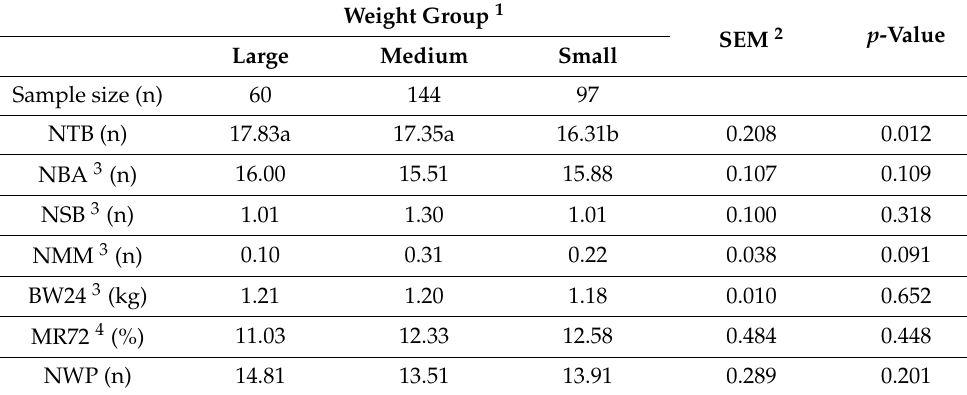
Table 2. Effect of body weight of gilts at first service on reproductive performance parameters from first insemination to first weaning on a commercial farm (NTB: number of total piglets born; NBA: number of piglets born alive; NSB: number of piglets stillborn; NMM: number of piglets mummified; BW24: piglet ´ s birth weight within 24 h; MR72: piglet mortality rate at 72 h postpartum; NWP: number of weaned